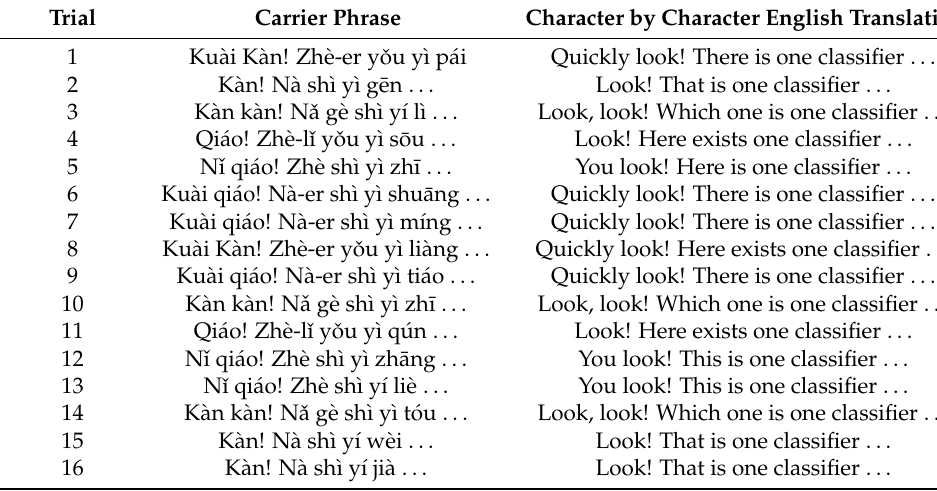
Table 2. Carrier phrases used in one of the